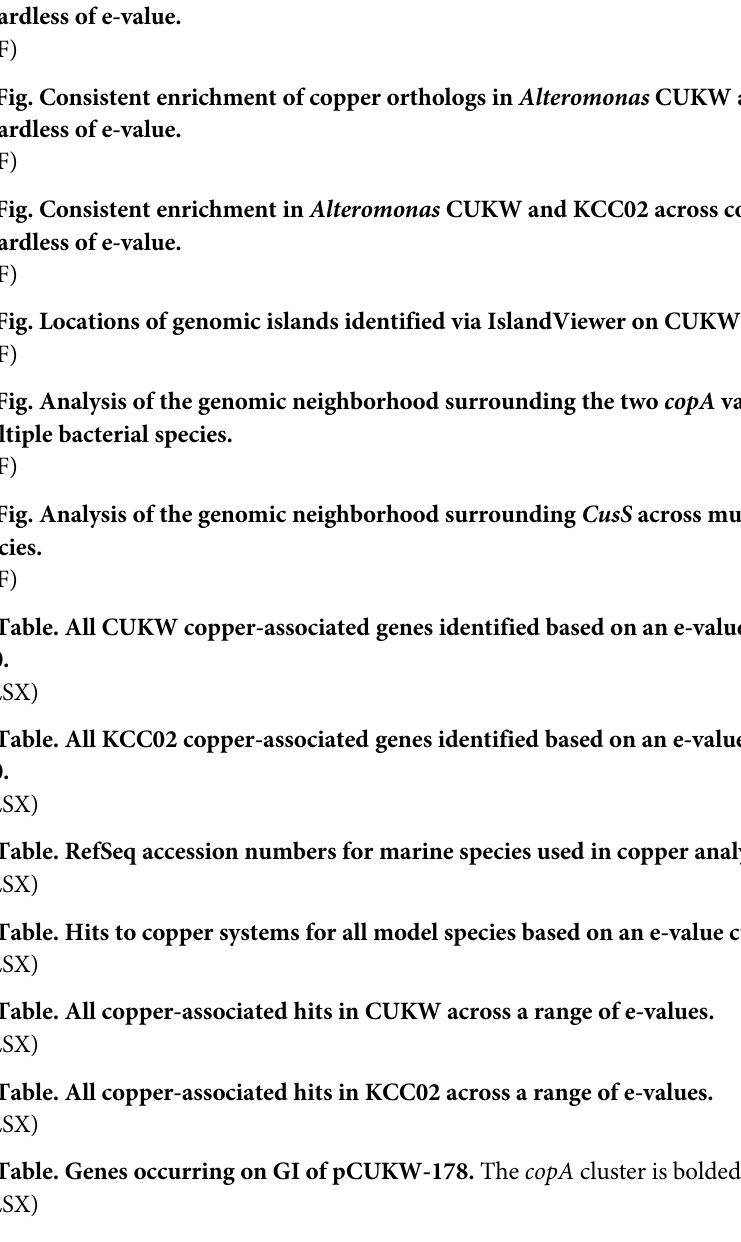
S2 Fig. A positive correlation exists across marine genera between decreasing e-value and number of copper-associated hits. (TIF) S3 Fig. Alteromonas CUKW and KCC02 show consistent enrichment across copper sys- tems regardless of e-value. (TIF) S4 Fig. Alteromonas CUWK and KCC02 show consistent enrichment across systems regardless of e-value. (TIF) S5 Fig. Consistent enrichment of copper orthologs in Alteromonas CUKW and KCC02 regardless of e-value. (TIF) S6 Fig. Consistent enrichment in Alteromonas CUKW and KCC02 across copper systems regardless of e-value. (TIF) S7 Fig. Locations of genomic islands identified via IslandViewer on CUKW chromosome. (TIF) S8 Fig. Analysis of the genomic neighborhood surrounding the two copA variants across multiple bacterial species. (TIF) S9 Fig. Analysis of the genomic neighborhood surrounding CusS across multiple bacterial species. (TIF) S1 Table. All CUKW copper-associated genes identified based on an e-value cut-off of 10 − 30. (XLSX) S2 Table. All KCC02 copper-associated genes identified based on an e-value cut-off of 10 − 30. (XLSX) S3 Table. RefSeq accession numbers for marine species used in copper analysis. (XLSX) S4 Table. Hits to copper systems for all model species based on an e-value cut-off of 10 − 30. (XLSX) S5 Table. All copper-associated hits in CUKW across a range of e-values. (XLSX) S6 Table. All copper-associated hits in KCC02 across a range of e-values. (XLSX) S7 Table. Genes occurring on GI of pCUKW-178. The copA cluster is bolded. (XLSX) S8 Table. List of genes located within each genomic island on the CUKW chromosome.